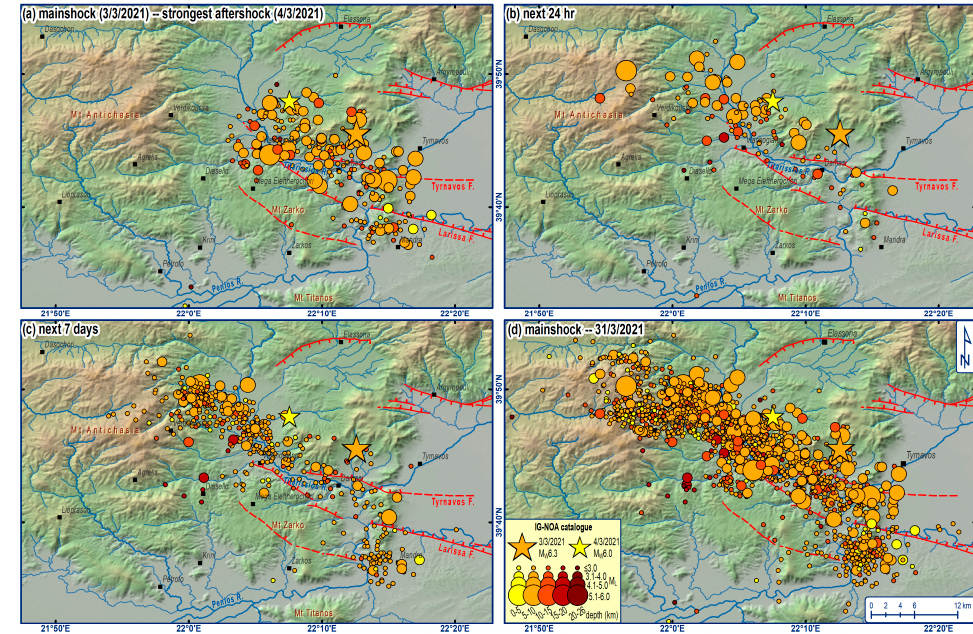
Figure 9. Spatiotemporal distribution of the 2021 earthquake sequence (epicentres from IG-NOA [58]) for the following periods: ( a ) from the first to the second strongest shocks, ( b ) for the next 24 h after ( a ), ( c ) for the next 7 days after ( b ), ( d ) the whole sequence until the end of March. Modified from Galanakis et al.